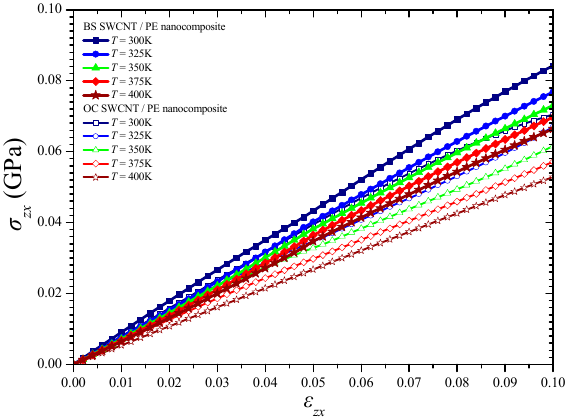
Figure 9. Shear stress–strain curves of the simulated NCs in the z - x plane for various temperatures.